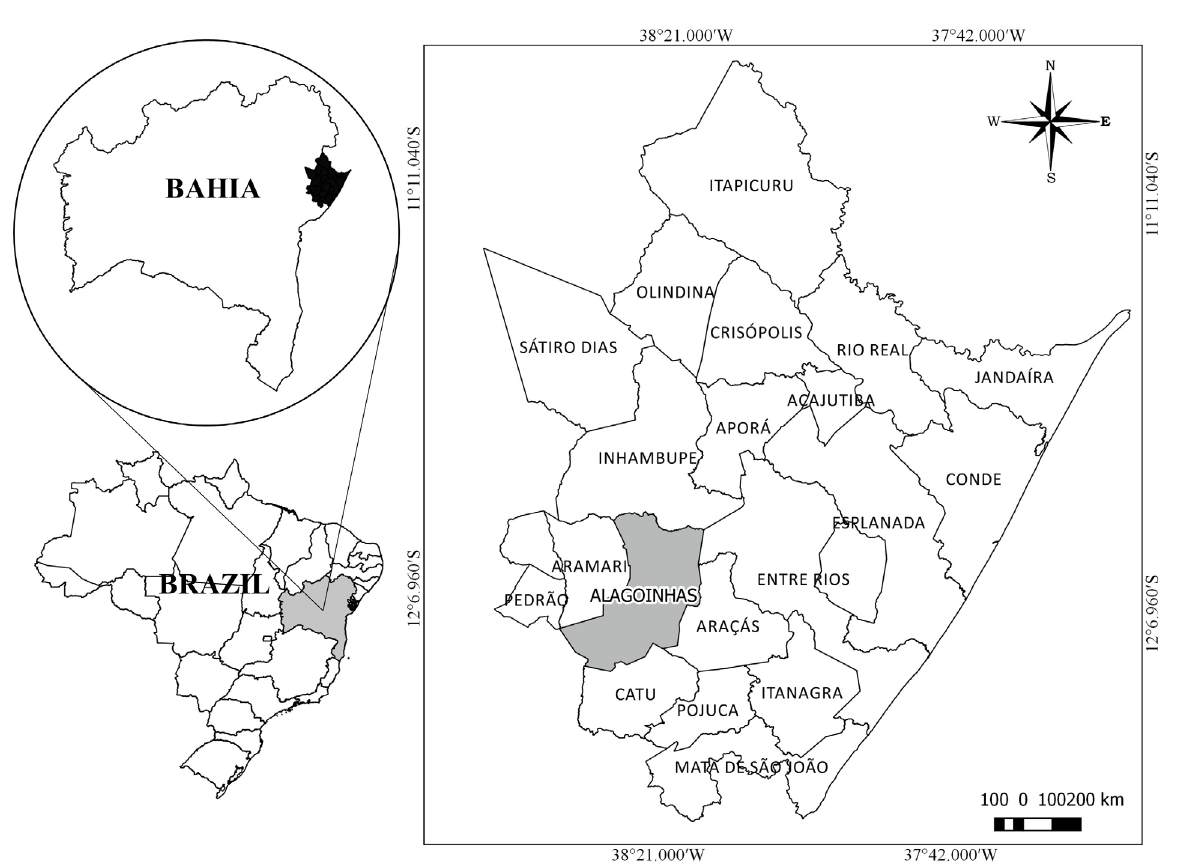
Fig 1 . Location of the Território de Identidade Litoral Norte e Agreste Baiano, with emphasis on the municipality of Alagoinhas – BA,